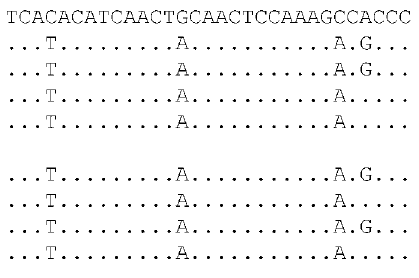
Figure 3. Sequences Obtained from the Neandertal Remains Using the ‘‘ Neandertal Primers ’’ Dots indicate identity to the human reference sequence (Anderson et al. 1981) given above. The four upper DNA sequences were determined in this study. Previously determined DNA se- quences are shown